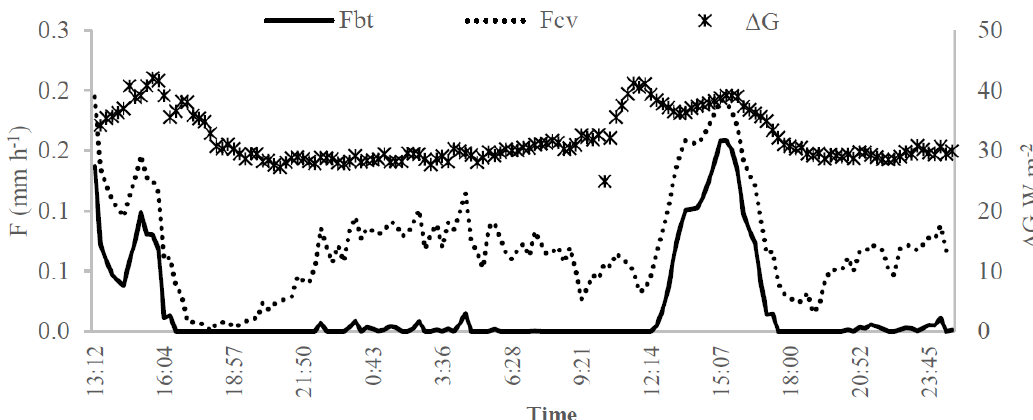
Figure 13. Circadian curves of the soil heat storage measured in days 14–15 October 2016 with the pair of Peltier cells (ΔG, W m −2 —empty circle—right vertical axis) and the sap flow rate measurement (F, mm h −1 —left vertical axis) with the Biot-Granier sensor set (SP32L) in function of the conventional (dash line) and Biot-Granier (full line) approaches (Experiment III).